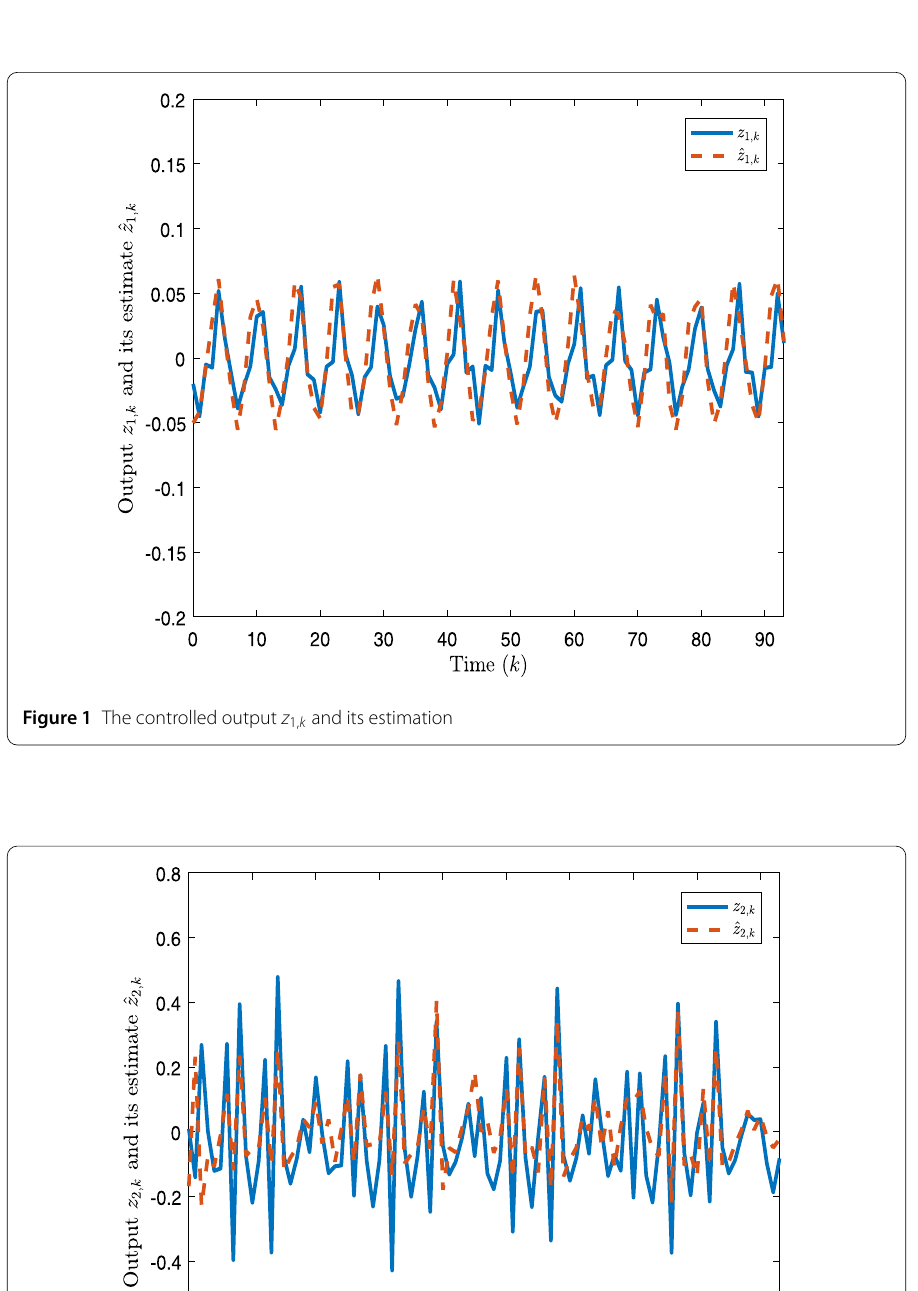
time-varying RNNs with the finite-time criterion as in [36] and the inaccuracy occurrence probability as mentioned in